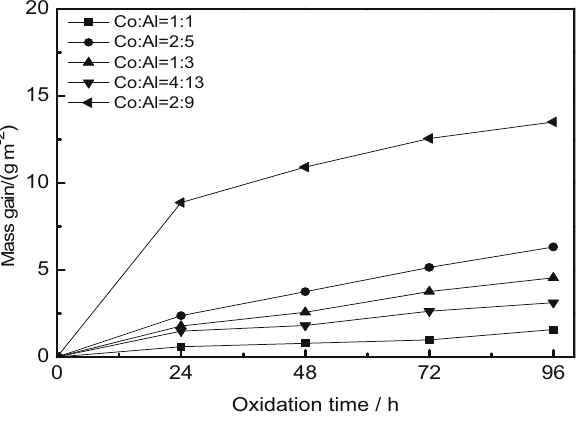
Figure 9: Mass gain of Co – Al porous products oxidized at 650°C and 2:9 retained their original cylindrical shape without any defects after sintering. The product of the specimen with Co:Al = 1:1 was a single CoAl intermetallic compound, and those with other Co/Al molar ratios were doped with minor or trace ingredients. The Al , intermetallics of Co – Al were mainly CoAl, Co 2 5 Co Al , and Co Al corresponding to their near Co/Al 4 13 2 9 molar ratio. The specimen with Co:Al = 1:1 possessed the values of 645.1°C and the highest open highest T ig porosity of 43.2%. The specimen with Co:Al = 2:9 values of 1420.9°C, the lowest possessed the highest T c density of 1.86 g cm − 3 , and higher open porosity of 42.8%. All Co – Al porous intermetallics had excellent high - temperature oxidation resistance than other porous intermetallics. We can add some pore - forming agents to increase Co – Al porous intermetallics porosity and decrease its density in future research.